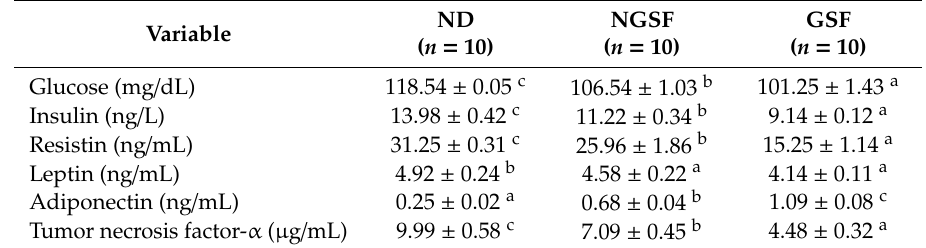
Table 4. Glucose profile and adipokine content in ovariectomized rats fed with non-germinated Superjami rice flour or germinated Superjami rice